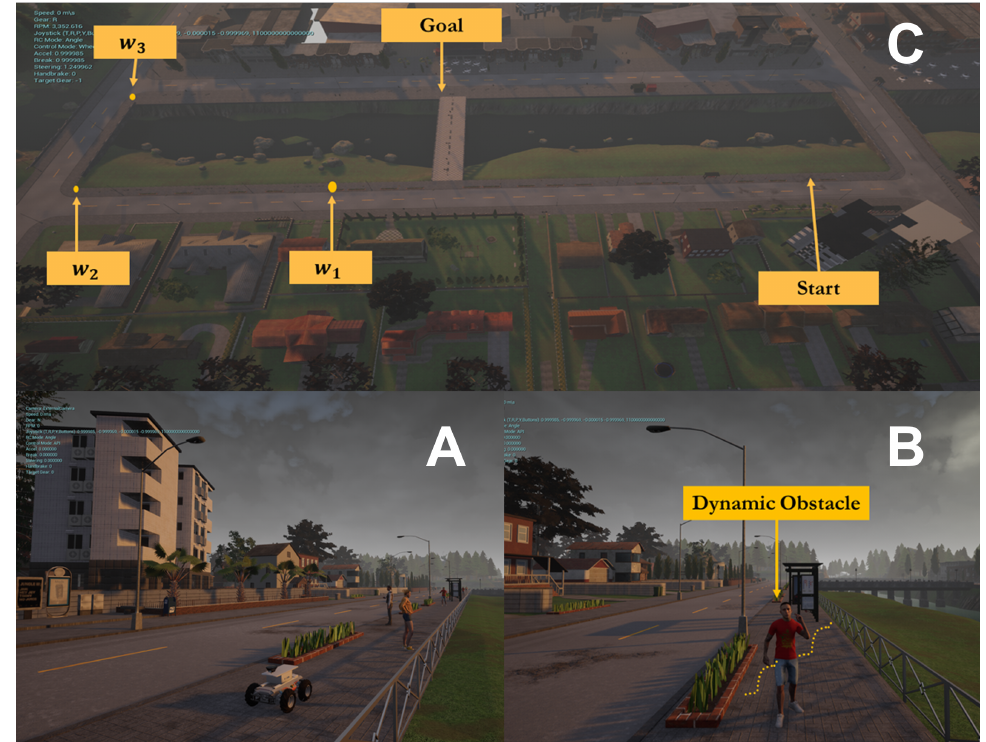
Figure 9. Simulation environment: ( A ) mobile robot with a forward facing camera. ( B ) Dynamic and static obstacles are included in the sidewalk. ( C ) Given a set of waypoints w 1 , w 2 , w 3 , the robot must reach the goal